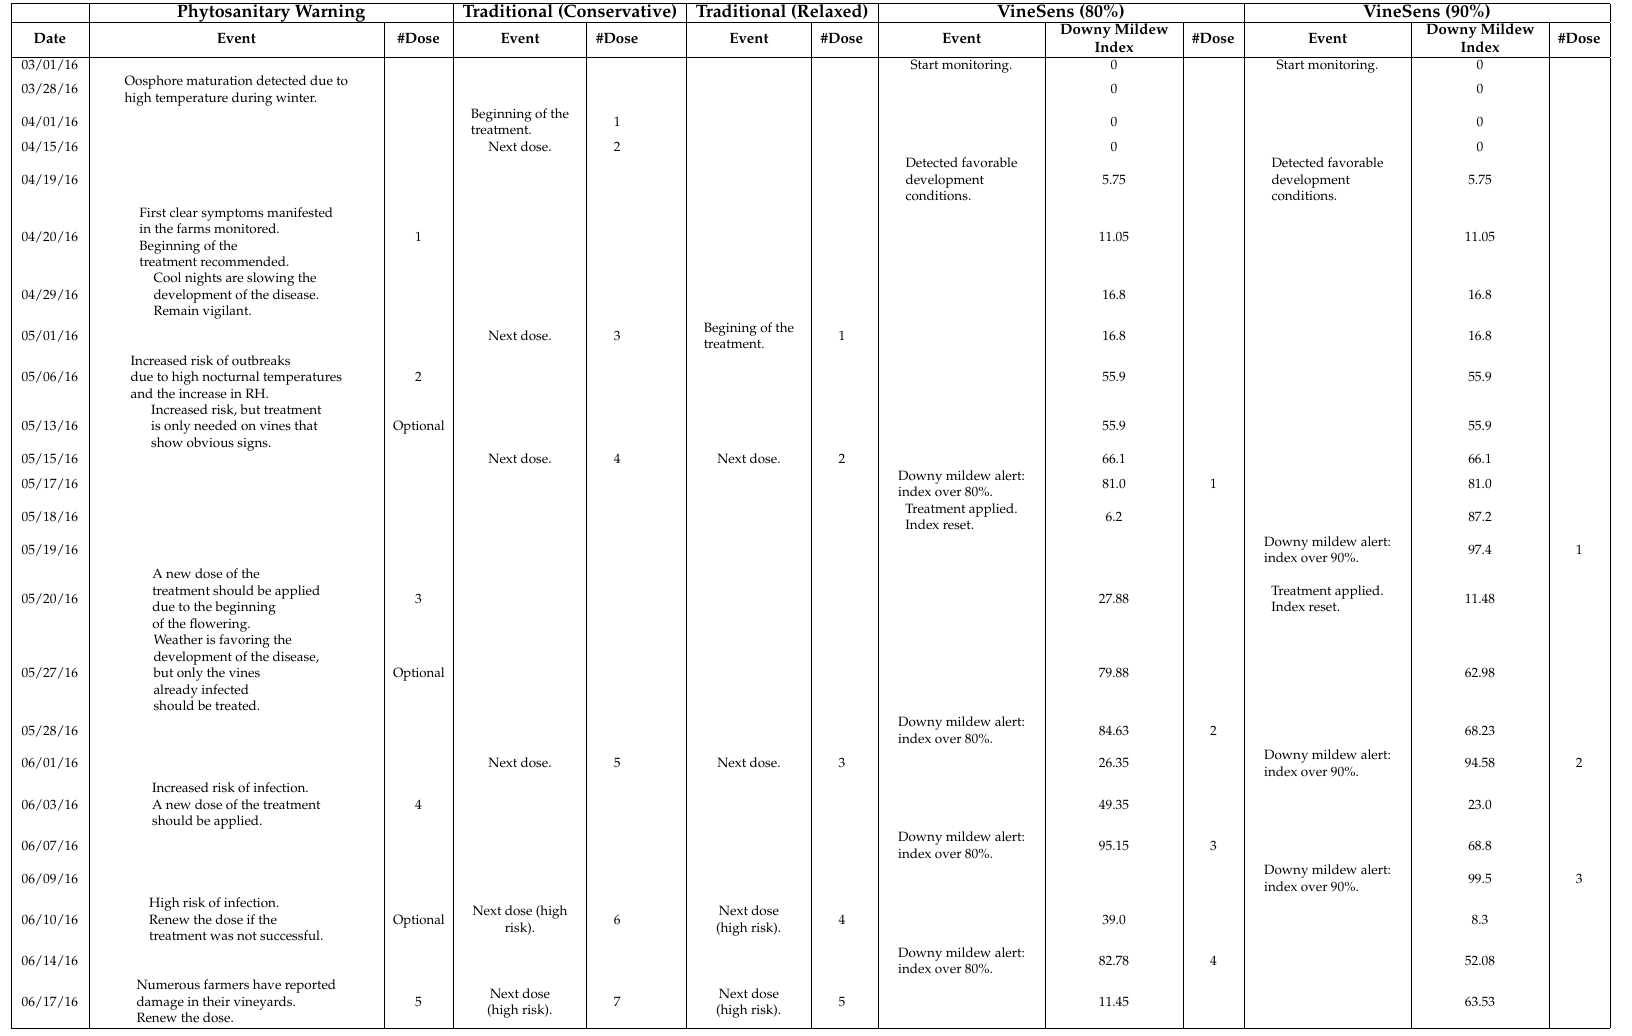
Table 6. Traditional downy mildew prevention methods versus VineSens (first